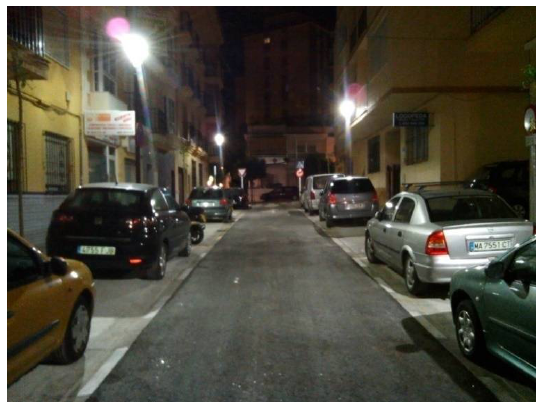
Figure 6. Spatial configuration of the luminaries related to the reference roadway of the field test in our study.